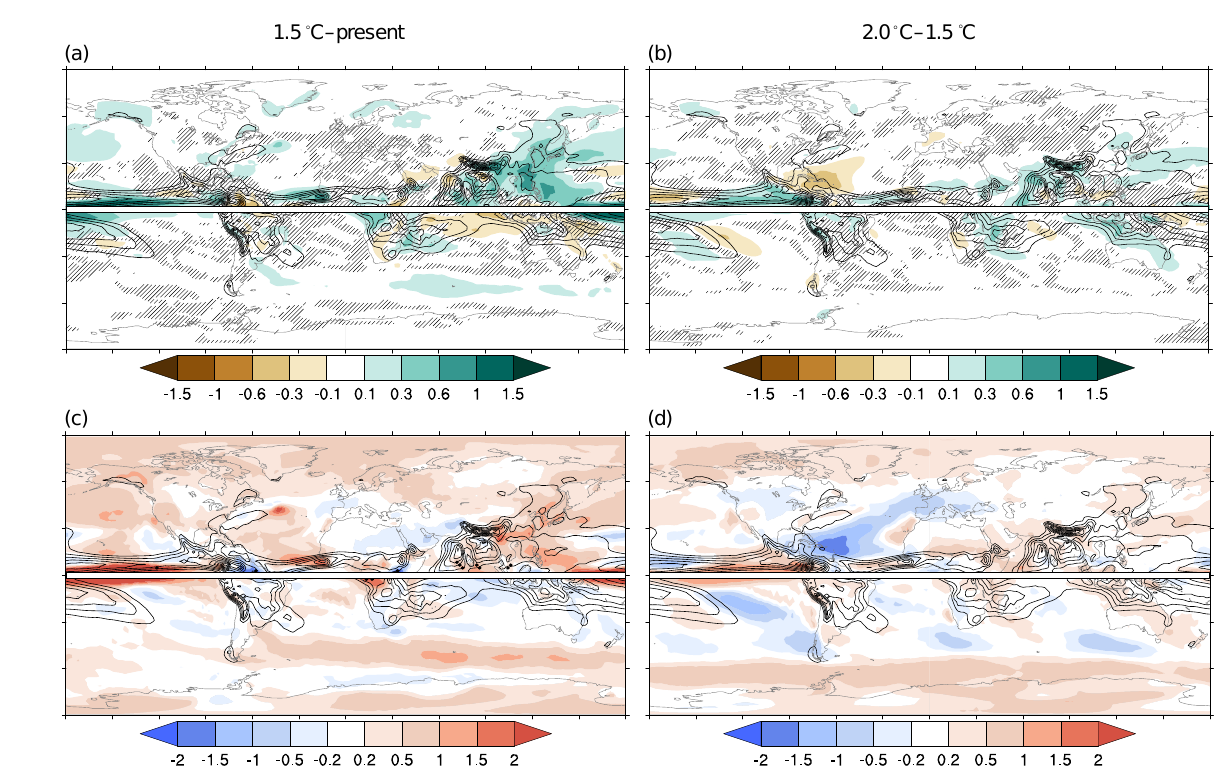
Figure 3. As in Fig. 2 but for summer (Northern Hemisphere JJA, Southern Hemisphere DJF) precipitation.